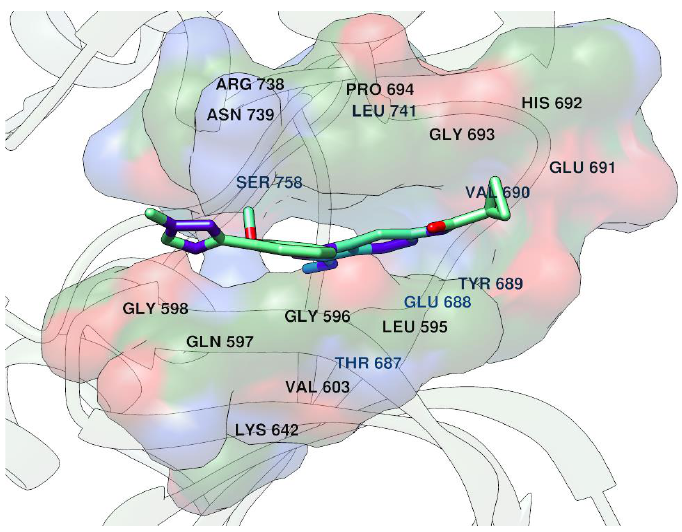
Figure 3. BMS-986165 binding mode into TYK2 JH2 domain (PDB entry code 6NZP).